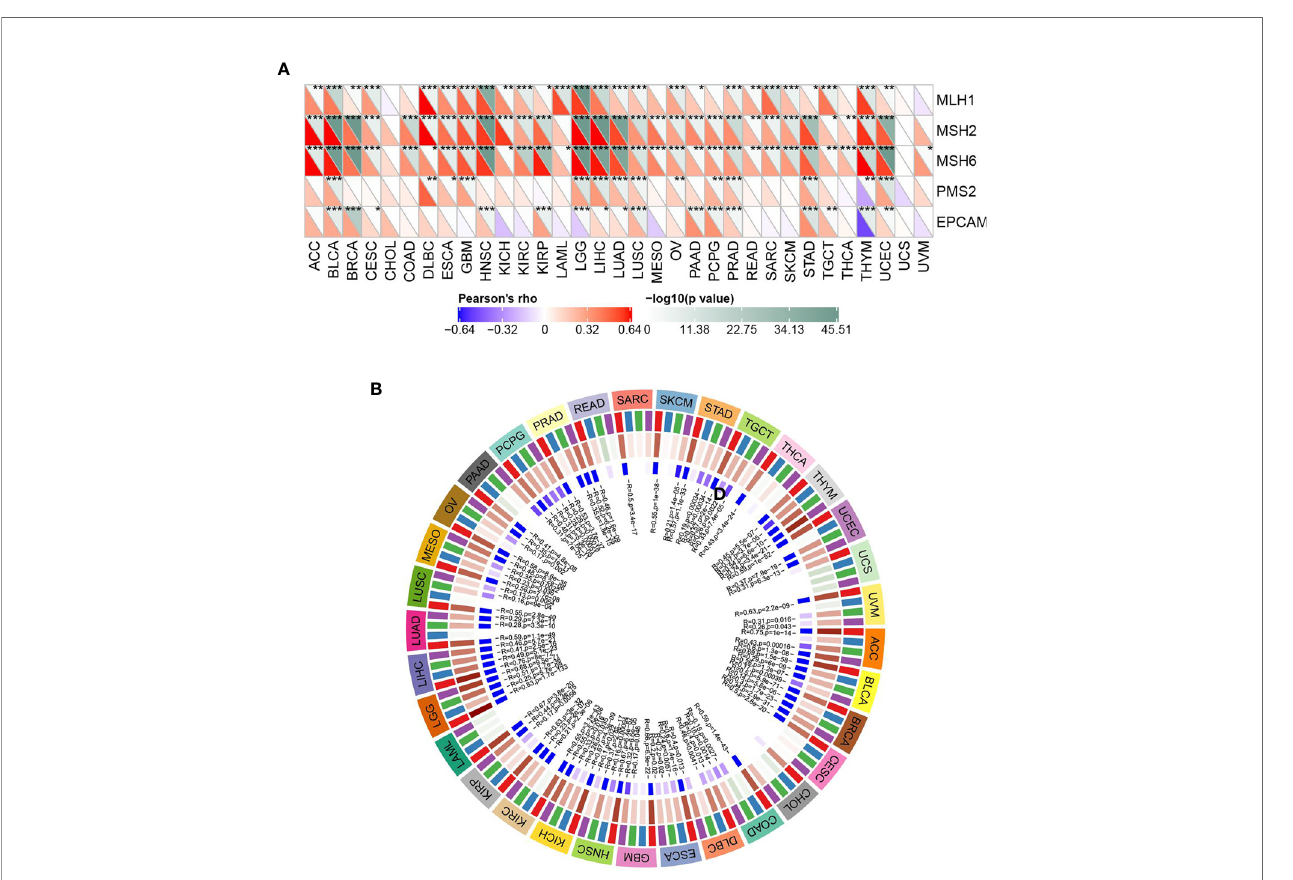
FIGURE 7 | ASF1B expression in relation to DNA repair genes and methyltransferases; (A) correlation between ASF1B expression and gene expression levels of fi ve MMRs; (B) correlation between ASF1B expression and expression of four methyltransferases; red: DNMT1, blue: DNMT2, green: DNMT3A, purple: DNMT3B. In (A) * is P < 0.05,** is P < 0.01, *** is P < 0.001.